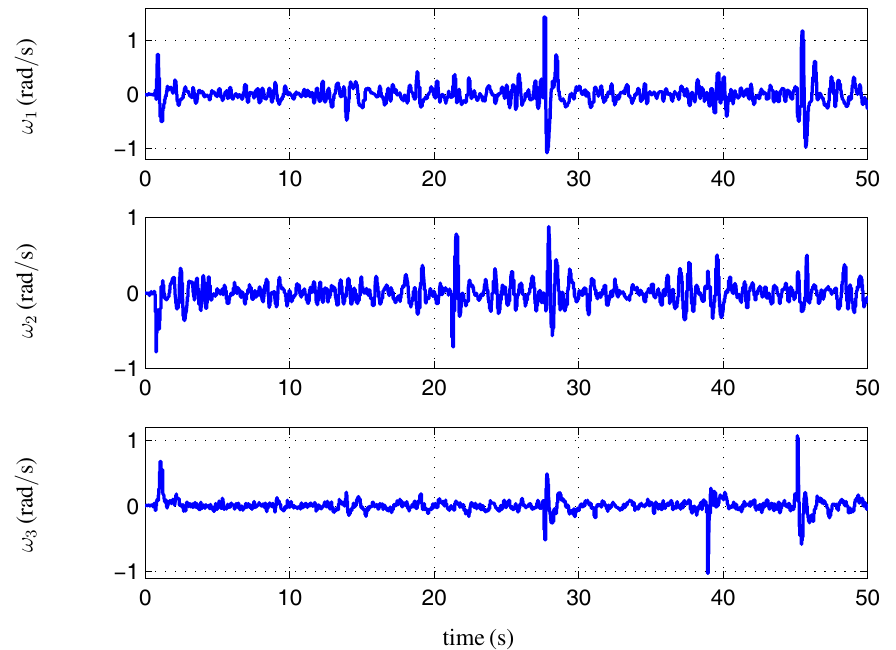
Figure 13. Control law of Corollary 2: the evolution of the body’s angular